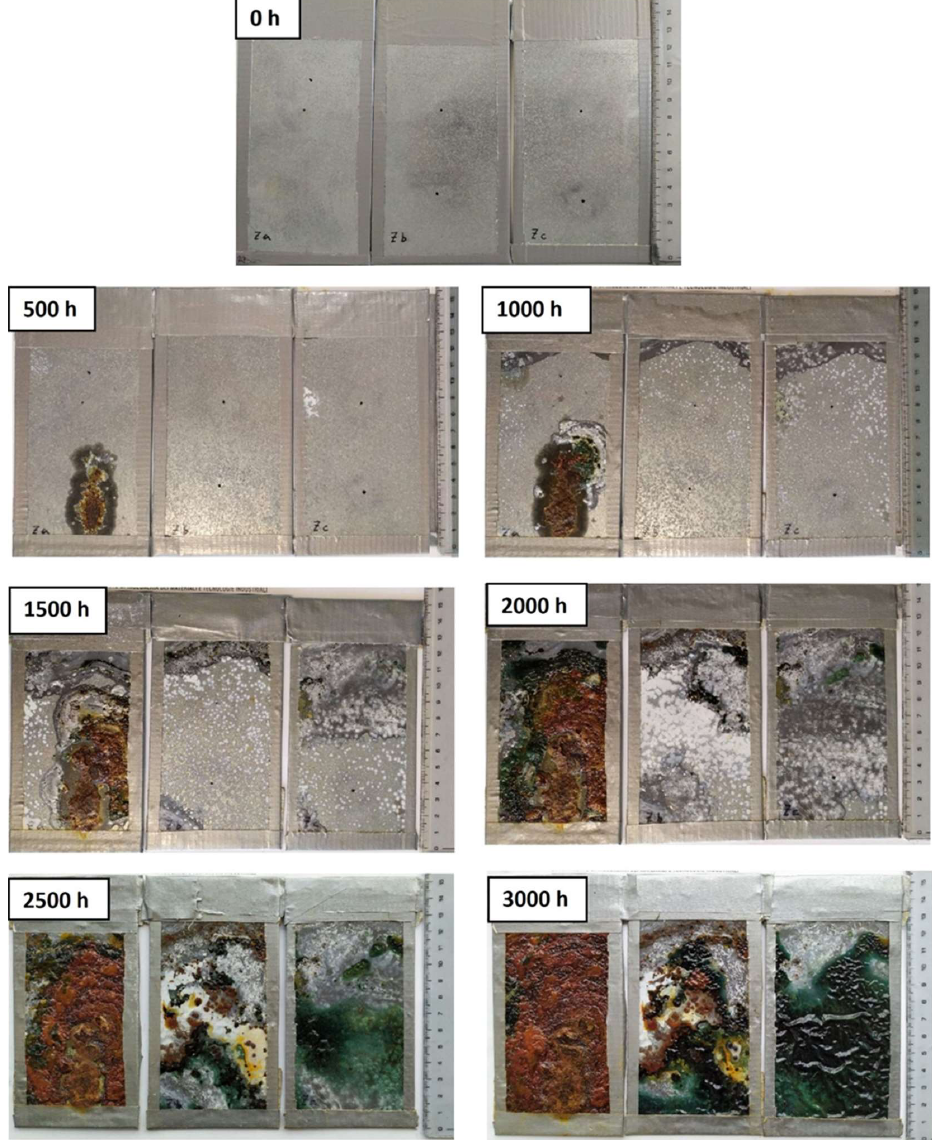
Figure 10. State of damage of painted HDG steel samples after 0, 500, 1000, 1500, 2000, 2500, and 3000 h of the prohesion.